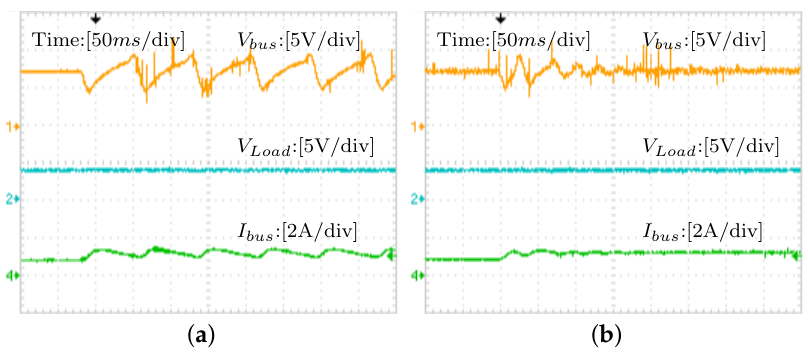
Figure 23. Experimental results the boost-driven cascaded system: ( a ) without the proposed controller; and ( b ) with the proposed